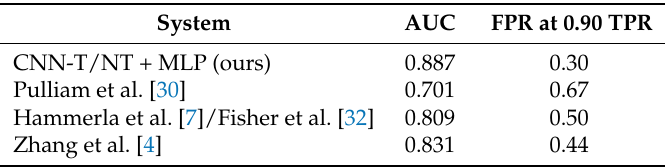
Figure 9. Comparing our best system (Convolutional Neural Network Trained on Spectra after Tremor Spectrum Extraction (CNN-T/NT) + MLP) on lab-recorded (LAB) data to previous systems proposed in the literature using leave-one-subject-out (LOSO) cross-validation. Table 4. AUC and FPR at 0.90 TPR on LAB